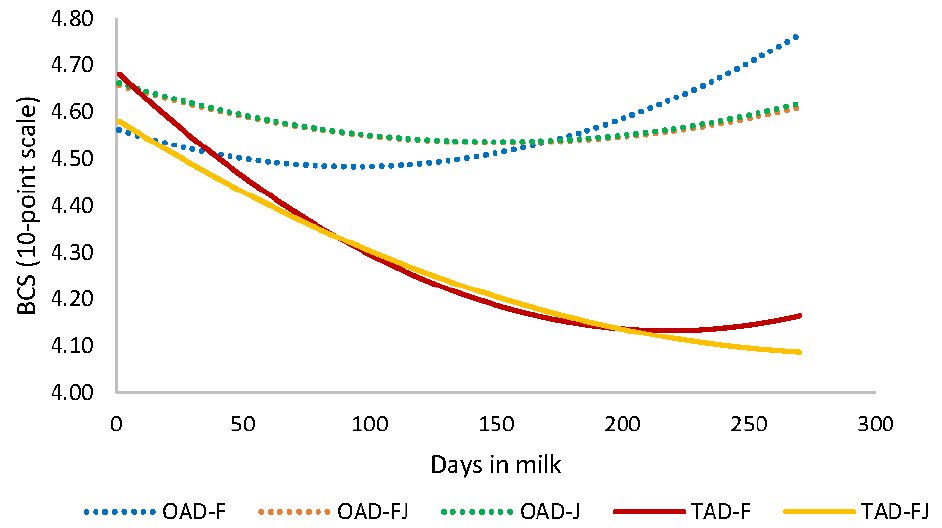
Figure 5. Body condition score of Holstein-Friesian, Holstein-Friesian × Jersey and Jersey cows milked OAD (….) and in TAD (—) on a 10-point scale during the 2020–2021 production season.